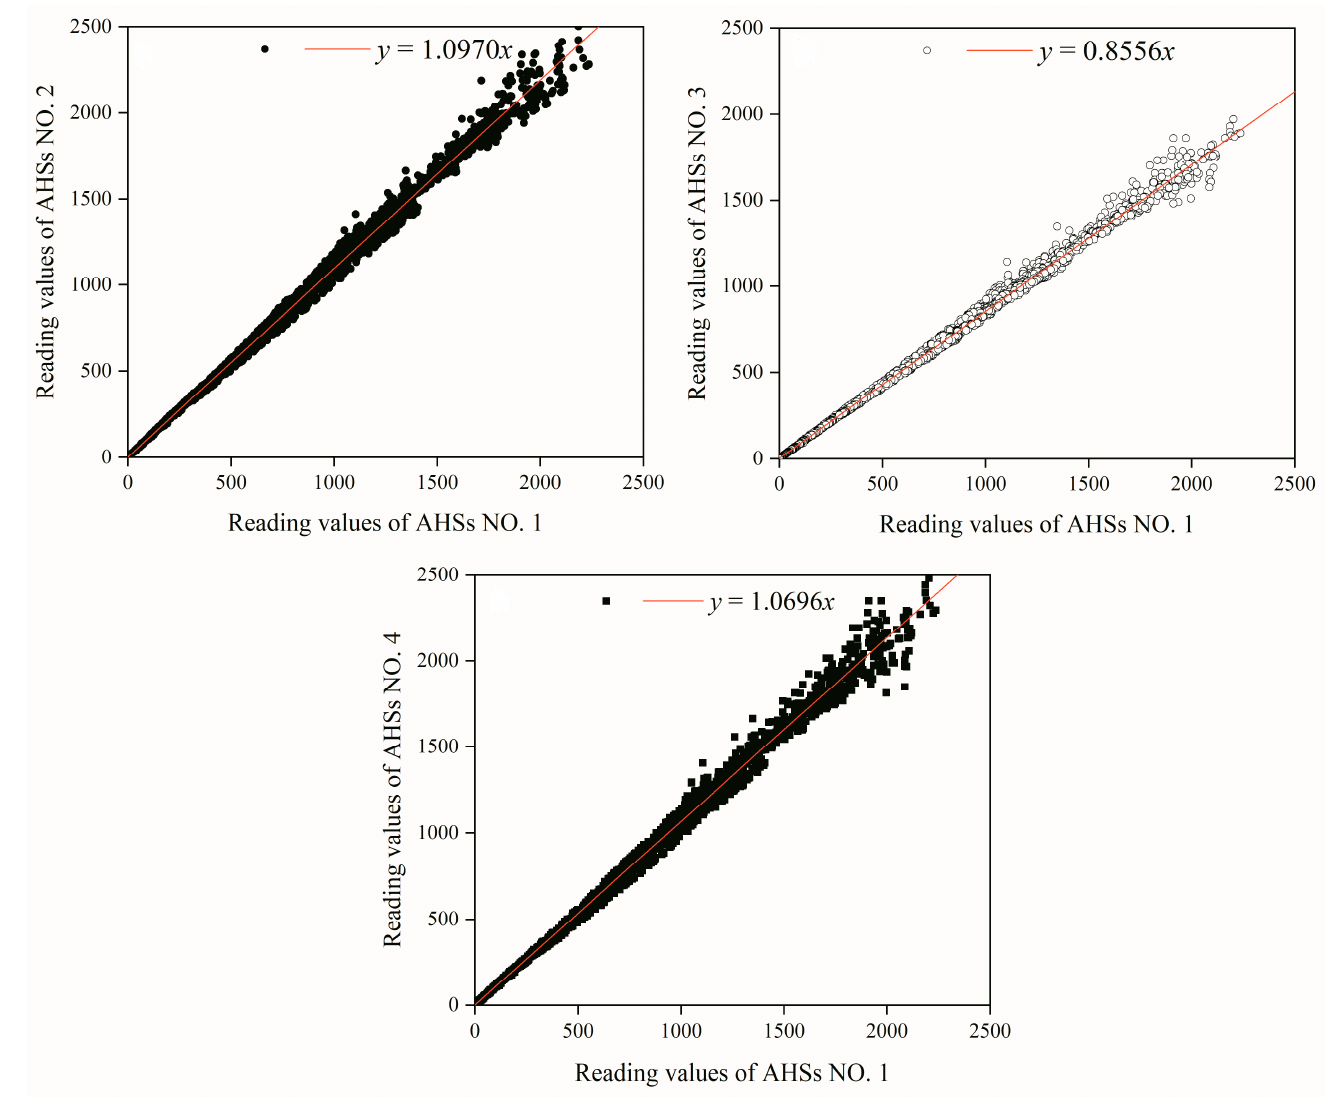
Figure 3. Comparison of values read by the four AHS S , No. 1 instrument measuring above-canopy values was used as a reference.